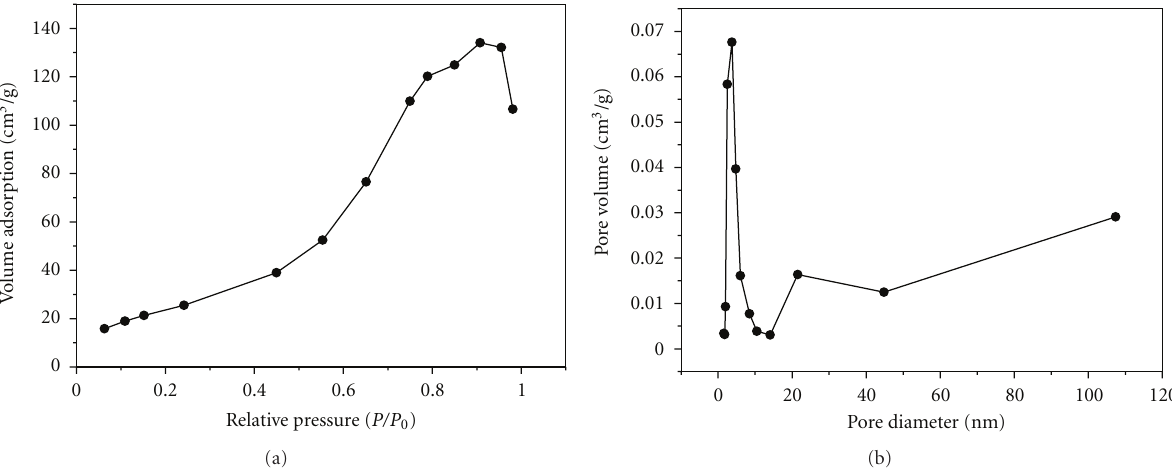
Figure 5: (a) N 2 desorption isotherms and (b) BJH pore size distribution of 3% B-TiO 2 samples calcinated at 400 ◦